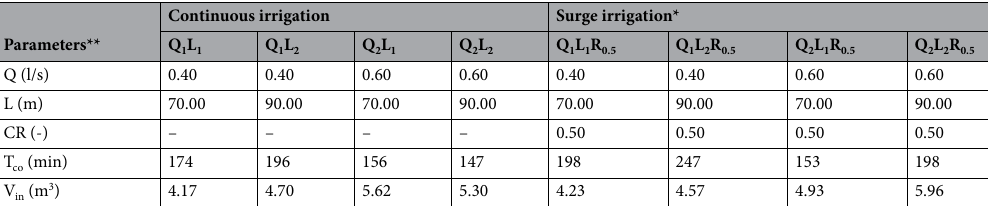
Table 2. Field characteristics information of the combination of furrow length and stream sizes under the continuous and surge irrigations. *Cycle time is 16 min in surge irrigation (8 min on-time + 8 min off-time). **Q: stream size; L: furrow length; CR: cycle ratio in surge irrigation; V in : volume of applied water; Tco: Cut-off time; R 0.5 : surge irrigation with cycle ratio of